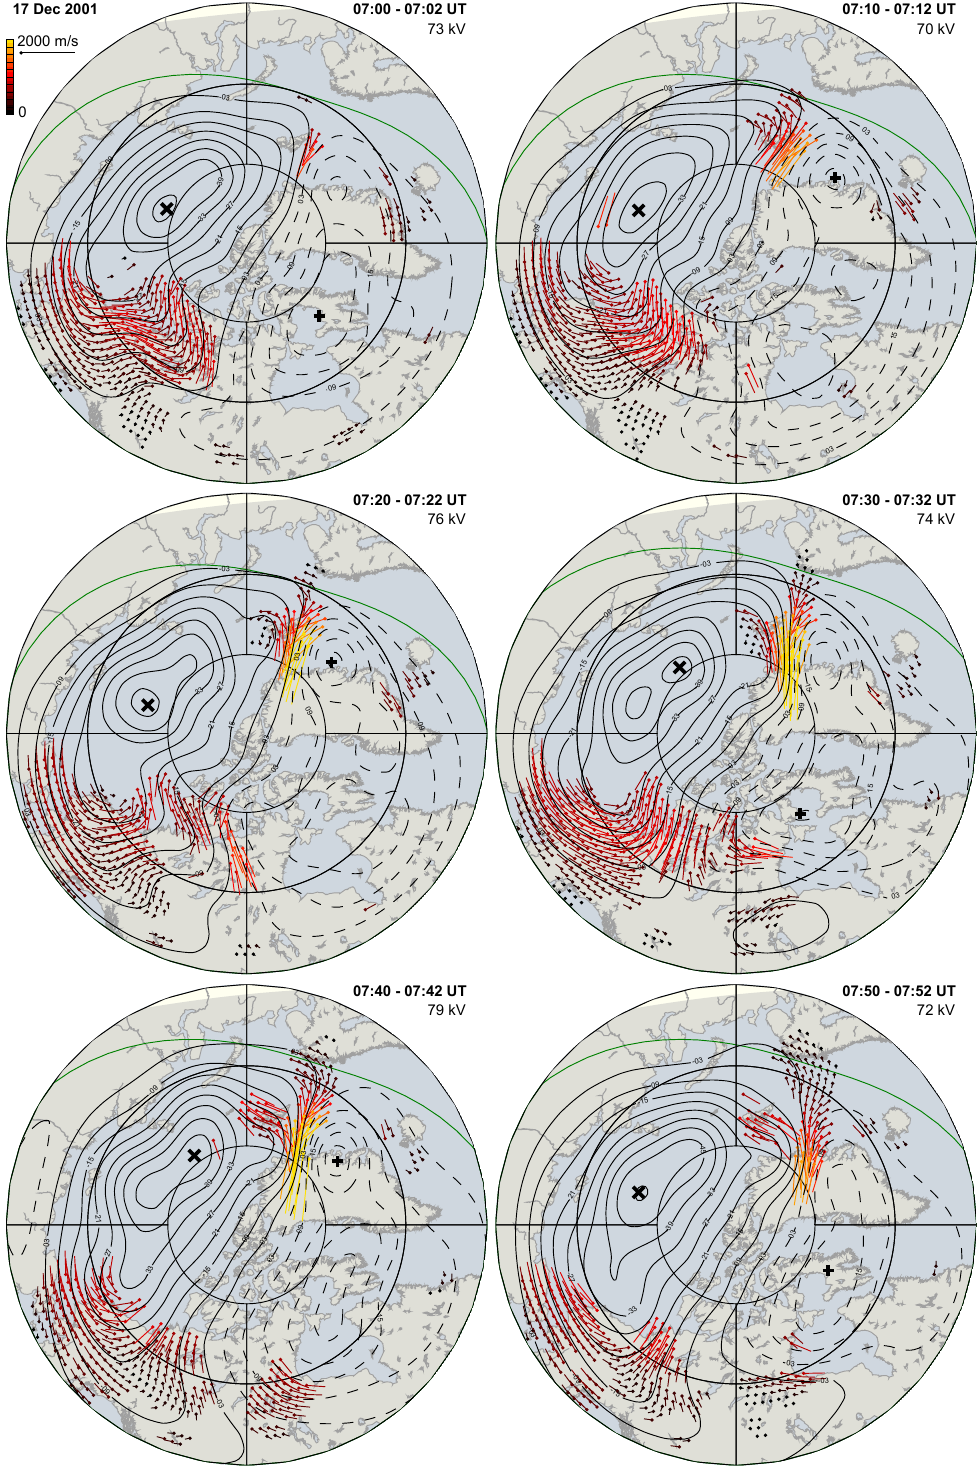
Fig. 6. SuperDARN potential patterns in 10min steps during the time range of this study. These data are consistent with a very stable IMF and large-scale flow over Svalbard at 07:00–07:22UT and a modest change